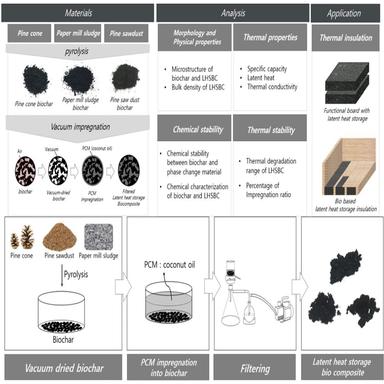
Framework of this research and preparation process of LHSBC.